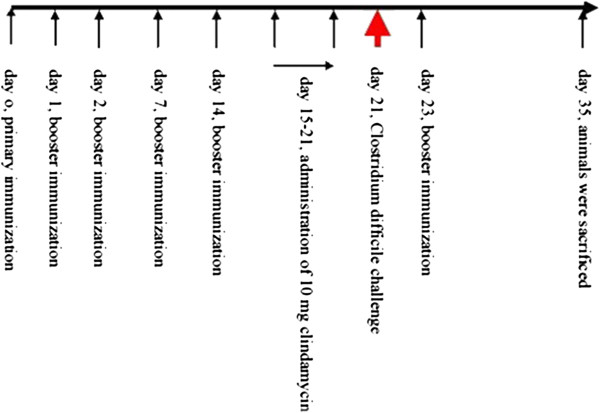
Schematic diagram of Clostridium difficile challenge experiment.